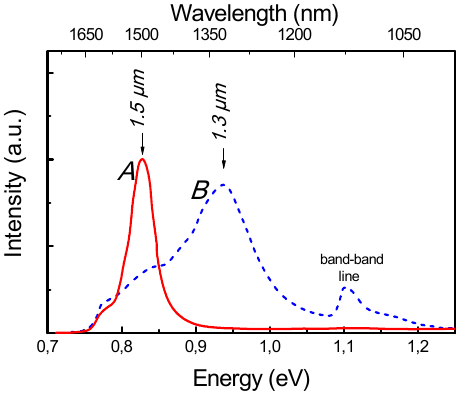
Figure 23. Impact of misorientation/structure on the luminescence spectra of dislocation networks: ( A ) twist angle of ϑ twist = 3°, dominating D1 peak; and ( B ) twist angle of ϑ twist = 8.2°, dominating D3 peak. The same tilt angle of ϑ twist = 0.2° exists in both cases [108].